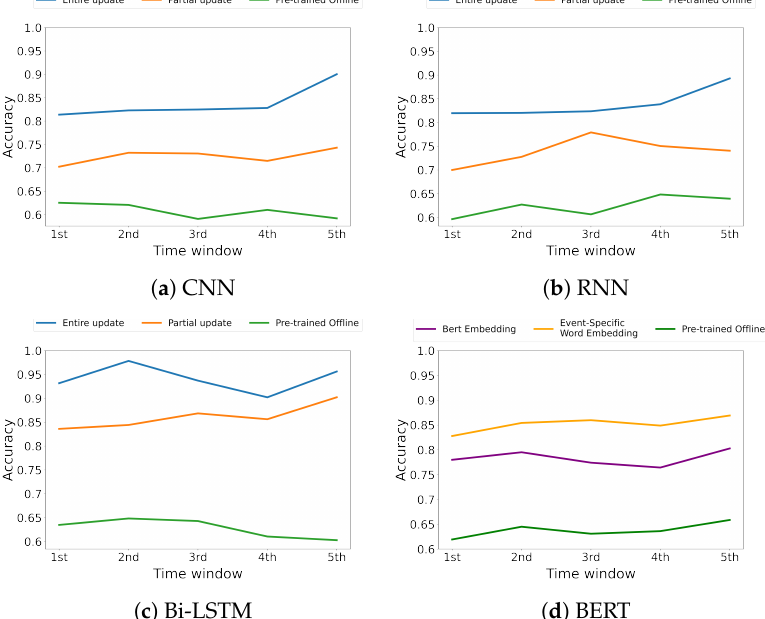
Figure 5. Accuracy comparison between (1) Pre-trained offline, (2) Entire model update, and (3) Partial model update on disaster